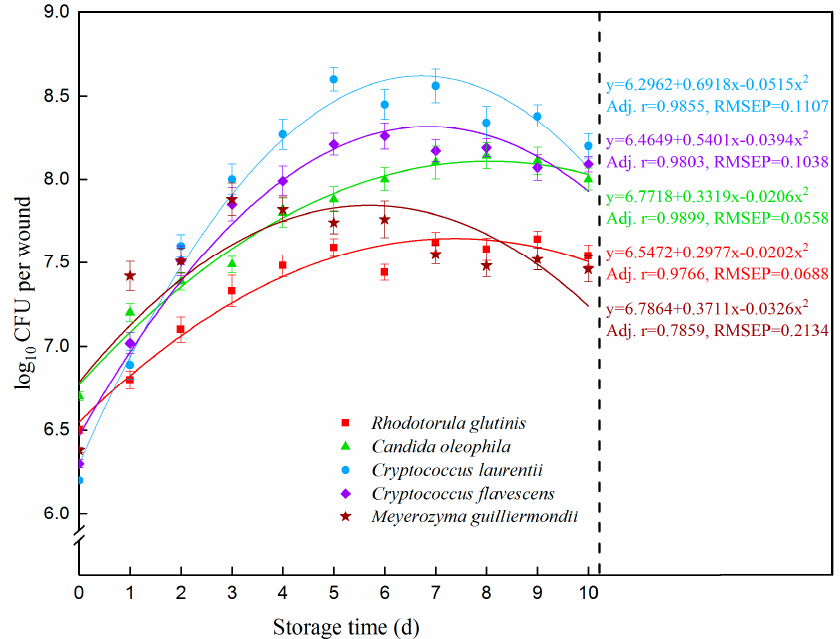
Figure 2. Population dynamics of five candidate yeasts. The concentrations are shown as mean ± SD, and the trend lines are constructed by polynomial regression. 3.4. In Vivo Preservative Effects of Candidate Antagonistic Yeasts on Fungi-Inoculated Peaches To determine the in vitro antifungal effect on and the colonizing capacity of film, Candida oleophila sp-ELPY12B and Cryptococcus laurentii sp-ELPY15A were finally chosen as microbiological additives in combination with a Na-alginate film solution (0.4% glycerin as plasticizer and 0.1% Tween-80 as emulsifier) for an in vivo preservative effect analysis, in practice. After the quality attributes of weight loss (WL), respiration rate (RR), soluble solid content (SSC), and the decay index (DI) had been evaluated every 2 d during